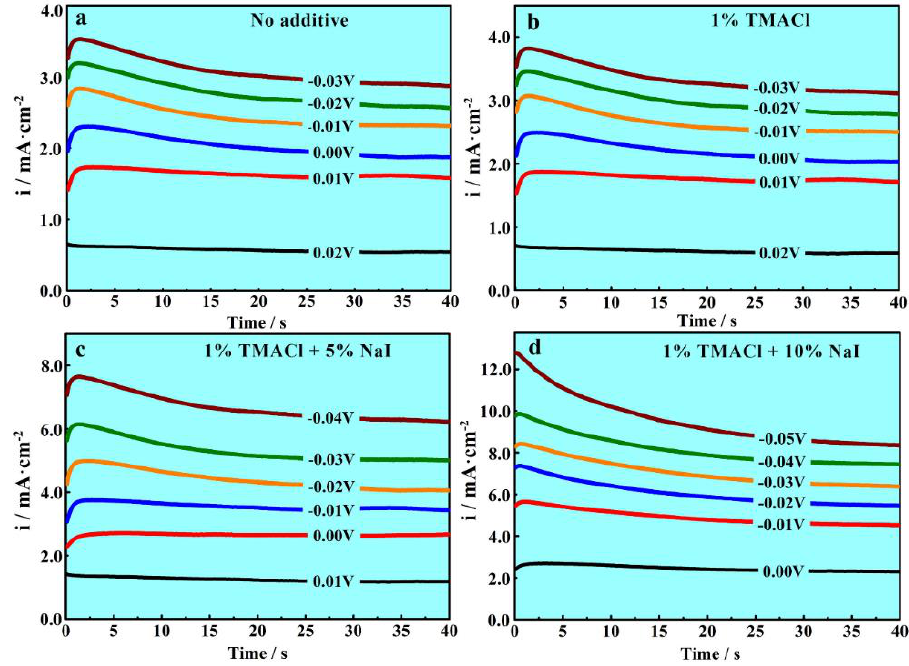
Figure 3. Typical current density–time transients of the electrodeposition experiments in the AlCl 3 -NaCl-KCl molten salts electrolyte, ( a ) no additive, ( b ) 1% TMACl, ( c ) 1% TMACl + 5% NaI and ( d ) 1% TMACl + 10% NaI, at 150 °C.